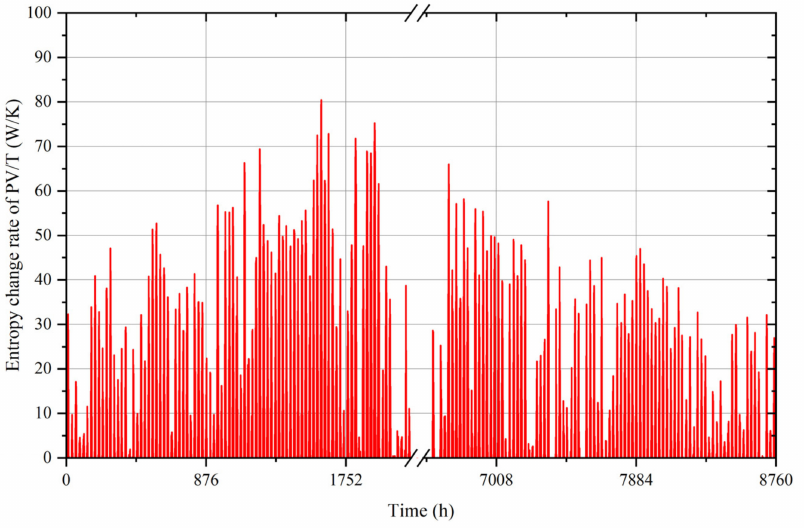
Figure 13. Entropy change of LCPV/T in heating season.